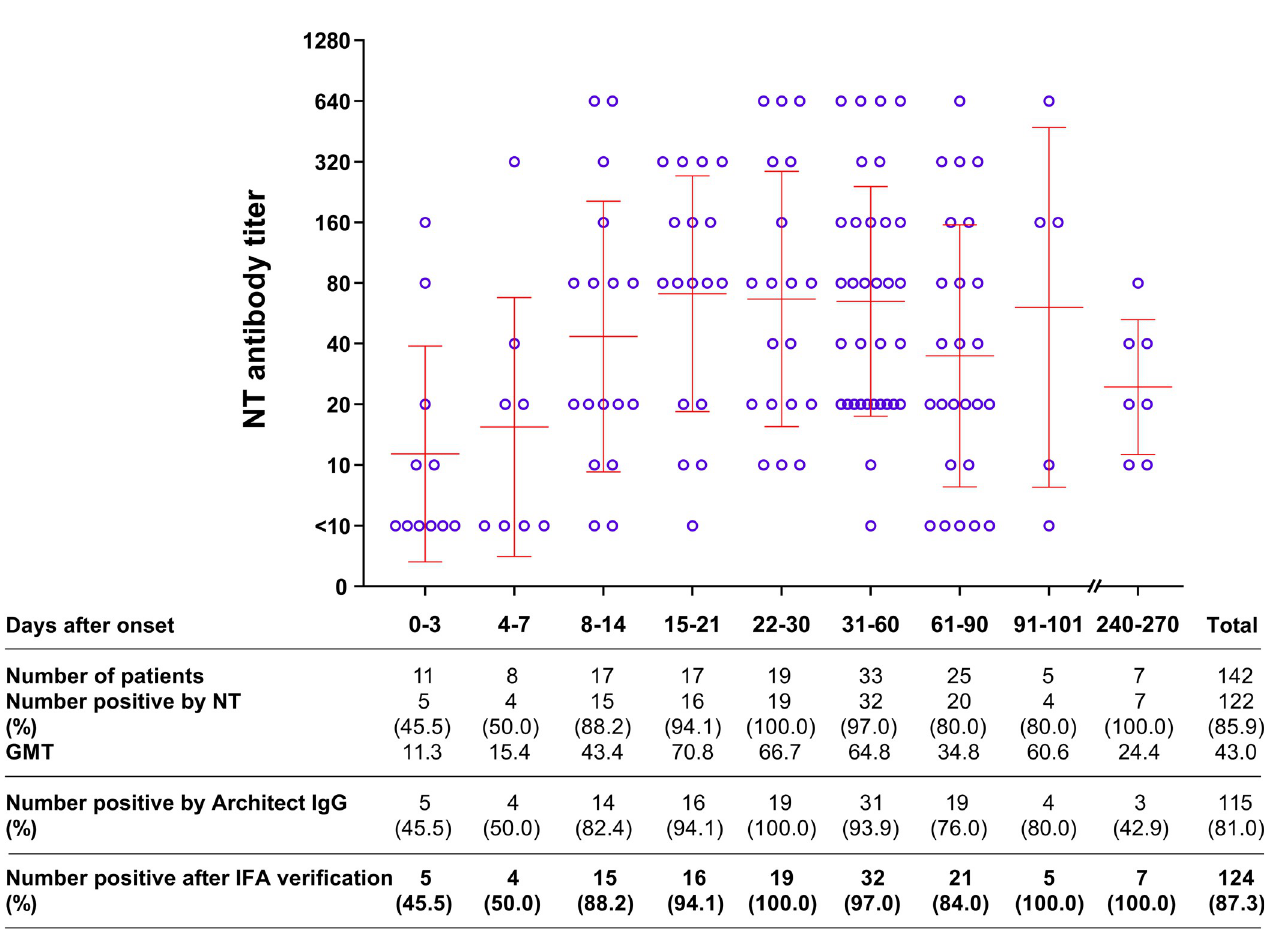
Fig 2. Antibody responses in COVID-19 patients at different time points after the onset of disease symptoms.